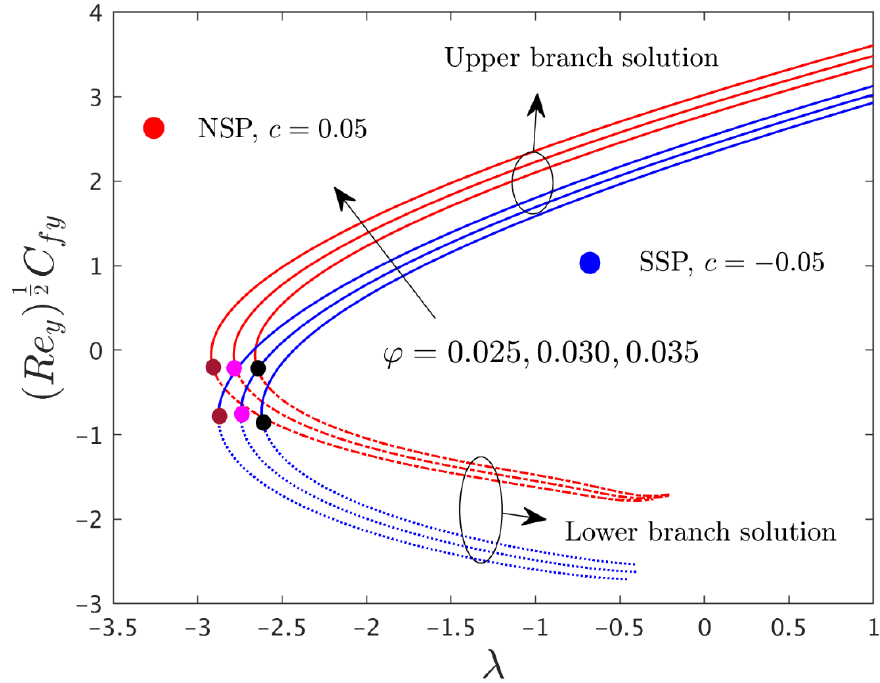
C in the x-axis direction for varying x f x